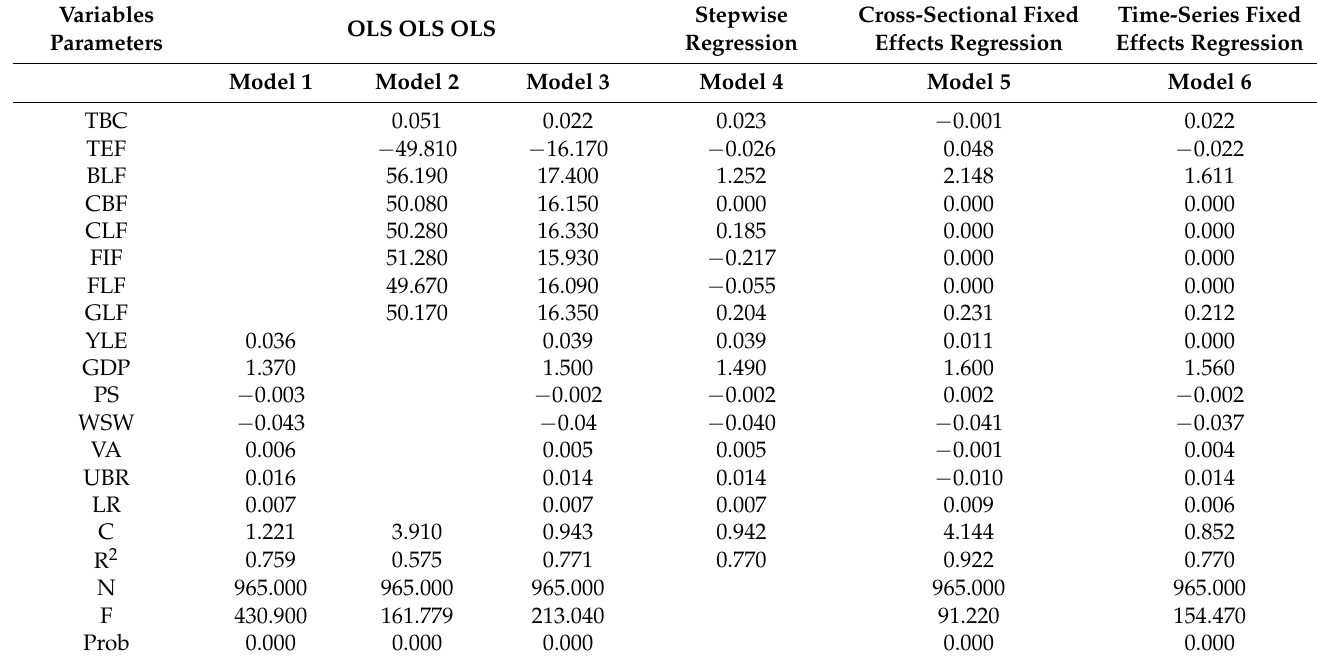
Table 2. Comparison of four regression